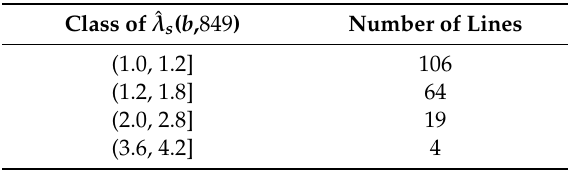
Table 9. Distribution of average N − 1 overloads at hour